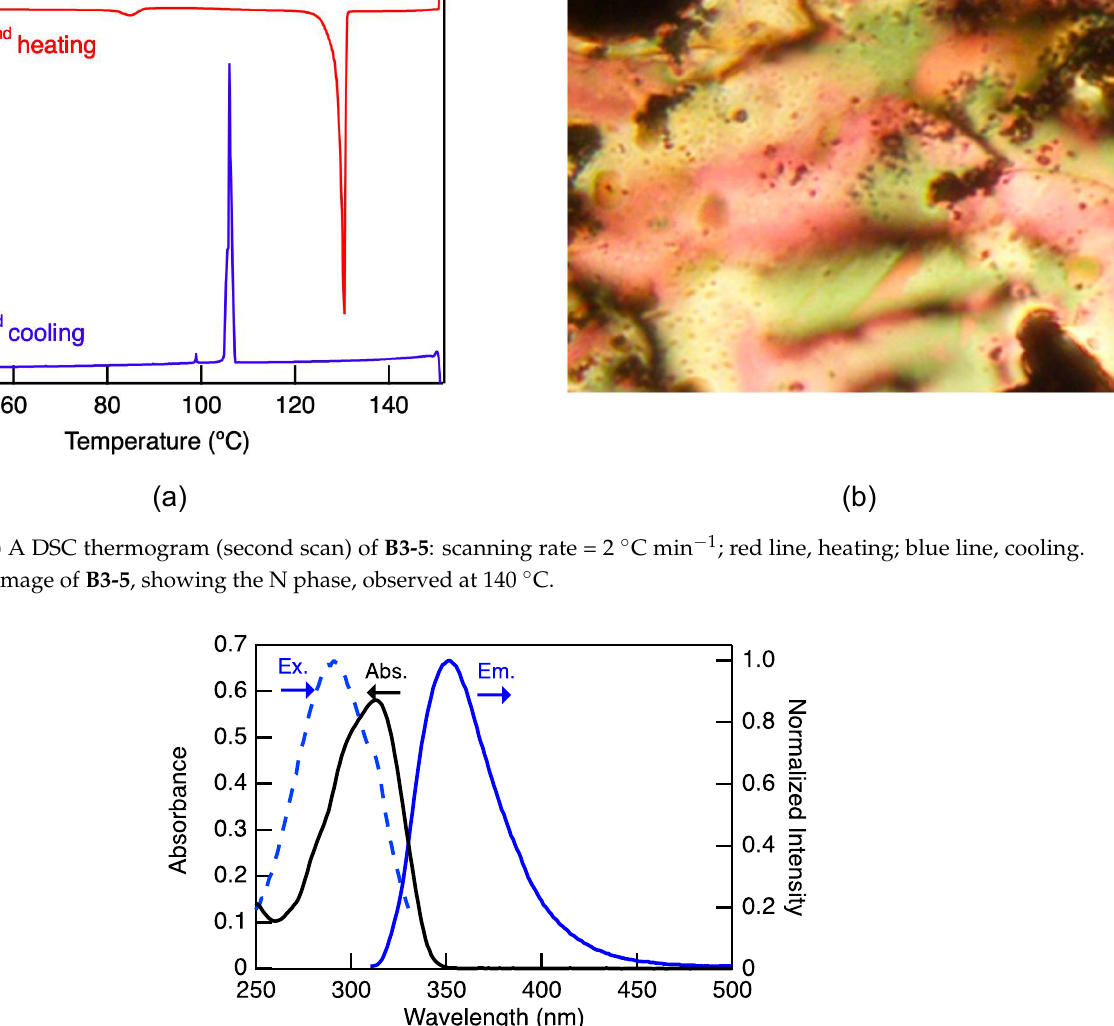
Figure 3. ( a ) Photophysical properties of B2-5 in a CH 2 Cl 2 solution: absorption, solid black line; emission, solid blue line; excitation, dashed blue line. [ B2-5 ] = 1 × 10 −5 mol L −1 for absorption spec- tra; [ B2-5 ] = 1.5 × 10 −6 mol L −1 for luminescence spectra. The excitation wavelength ( λ ex ) was 291 nm. Excitation spectra were monitored at 348 nm.